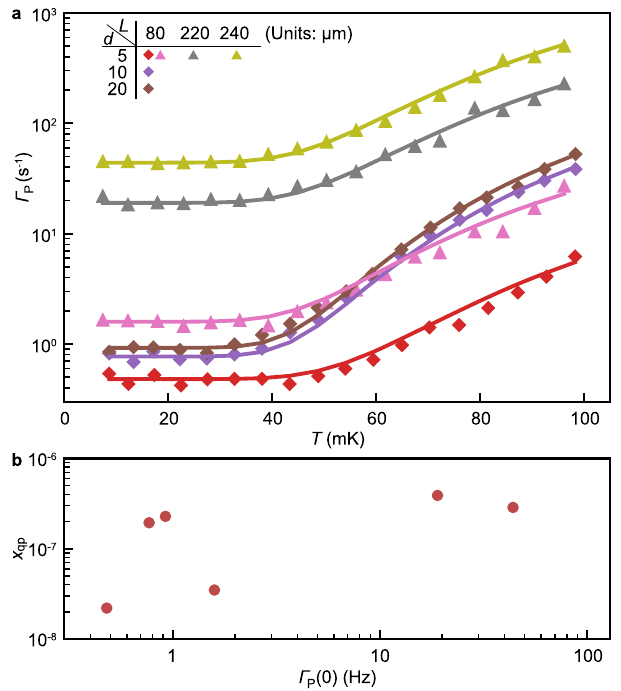
Fig. 4 | Effect of temperature on parity switching. a Parity switching rates mea- sured at n g =0 as a function of the nominal mixing chamber temperature T for several uncapped qubits with different L and d , whose combinations are colour- coded. Symbols identify different samples. The solid lines are fi t to Eq. (3). All curves share the same value for the superconducting gap in the pads (2 Δ 0 / h =87 GHz)andinthejunctionleads(2 Δ / h ≃ 99 − 105GHz(SupplementaryMaterial))ona given chip. The only remaining free parameter for a single qubit is the normalized quasiparticle density x qp . b Extracted quasiparticle density x qp plotted versus the low-temperature parity switching rate Γ P